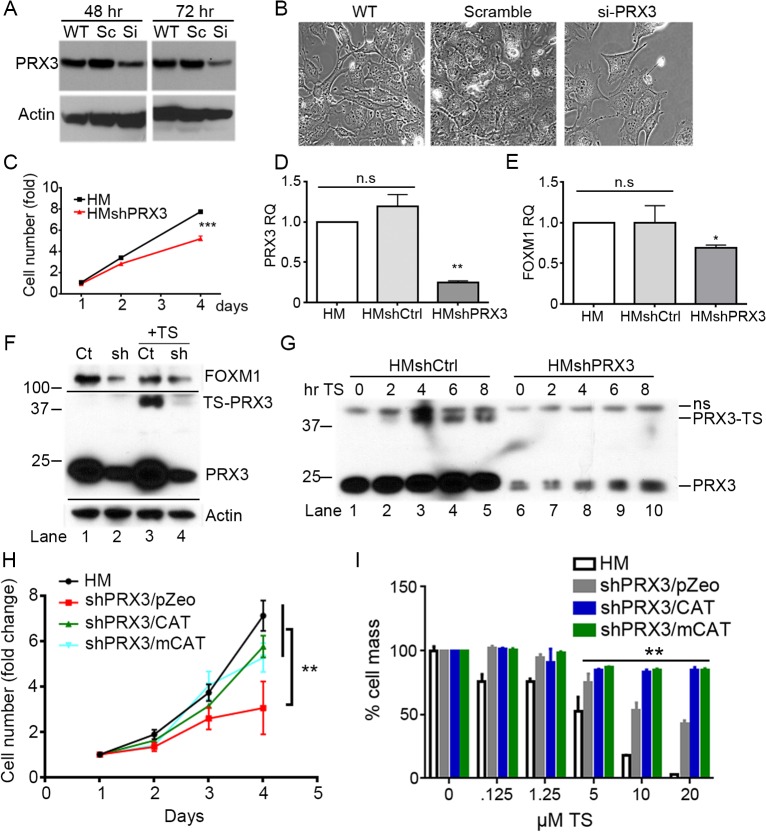
shPRX3 cells are less sensitive to TS than WT MM cells.(A) PRX3 expression in cells treated with scrambled control (Sc) or PRX3 siRNA for 48 and 72 hr. (B) Cell morphology and density of cells as treated in panel A after 72 hr. (C) Cell number in HMshPRX3 cells as compared to controls over 4 days (n = 4, *** p < 0.001). (D and E) Transcript levels for PRX3 and FOXM1 in WT HM, HMshCtrl cells and HMshPRX3 cell lines (** p < 0.01, * p < 0.05, n.s. = not significant). (F) Cell lysates from HMshCtrl and HMshPRX3 cell lines incubated with 5 μM TS for 18 hr were examined for PRX3, FOXM1, and actin expression by immunoblotting after denaturing SDS-PAGE. (G) HMshCTRL and HMshPRX3 cells were treated with 5 μM TS, lysates were collected over time and examined for PRX3 by immunoblotting (ns = non-specific band). (H) Cell number in shPRX3/pZeo, shPRX3/CAT, and shPRX3/mCAT cells compared to HM controls measured over 4 days (n = 4), ** p < 0.01) (I) HM controls, shPRX3/pZeo, shPRX3/CAT, and shPRX3/mCAT cells were incubated with increasing concentrations of TS for 18 hr, and total cell mass was determined by staining with crystal violet (n = 4, ** statistically significant all groups compared to HM, p <0.01). Error bars represent SEM. See also S3 Fig.